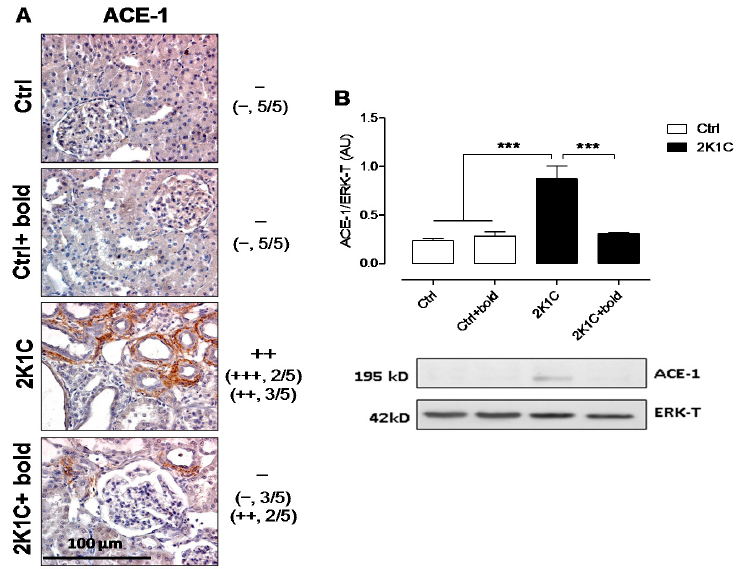
Figure 6. Boldine decreased ACE-1 expression in renal tissue of 2K1C hypertensive rats. Immunostaining for ACE-1 was performed in renal samples six weeks after 2K1C rats were made with hypertension ( A ). Representative pictures of at least five different kidneys are shown. Scale bar = 100 µ m. Brown staining represents ACE-1 presence. Morphometric semi-quantitative analysis for ACE-1 was performed on a scale of negative to three crosses ( − to +++), defined according to the degree of immunoreactivity observed in the renal tissue sample ([ − ] = 0–10%, [+] = 10–40%, [++] = 40–70% and [+++] = 70–100%) ( A ); In ( B ) a Western blot for ACE-1 is shown, with pictures of ACE1 bands and T-ERK used as the loading control. Bars represent the mean ± SE. The differences were evaluated by analysis of variance followed by the Tukey post-hoc test. *** p < 0.001 vs. 2K1C ( n = 5/all groups).